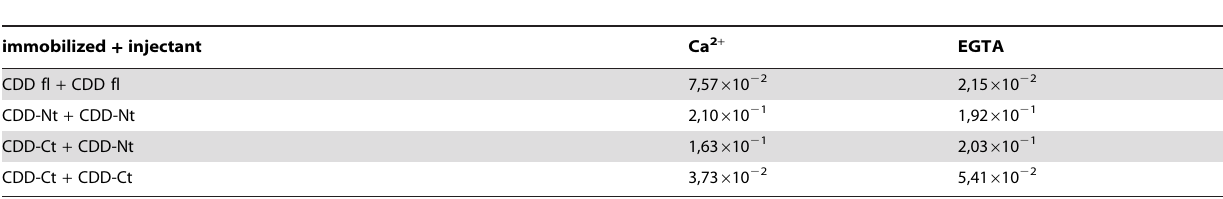
Table 2. Molar binding activity for different dimer combinations in the presence of Ca 2 + and EGTA.